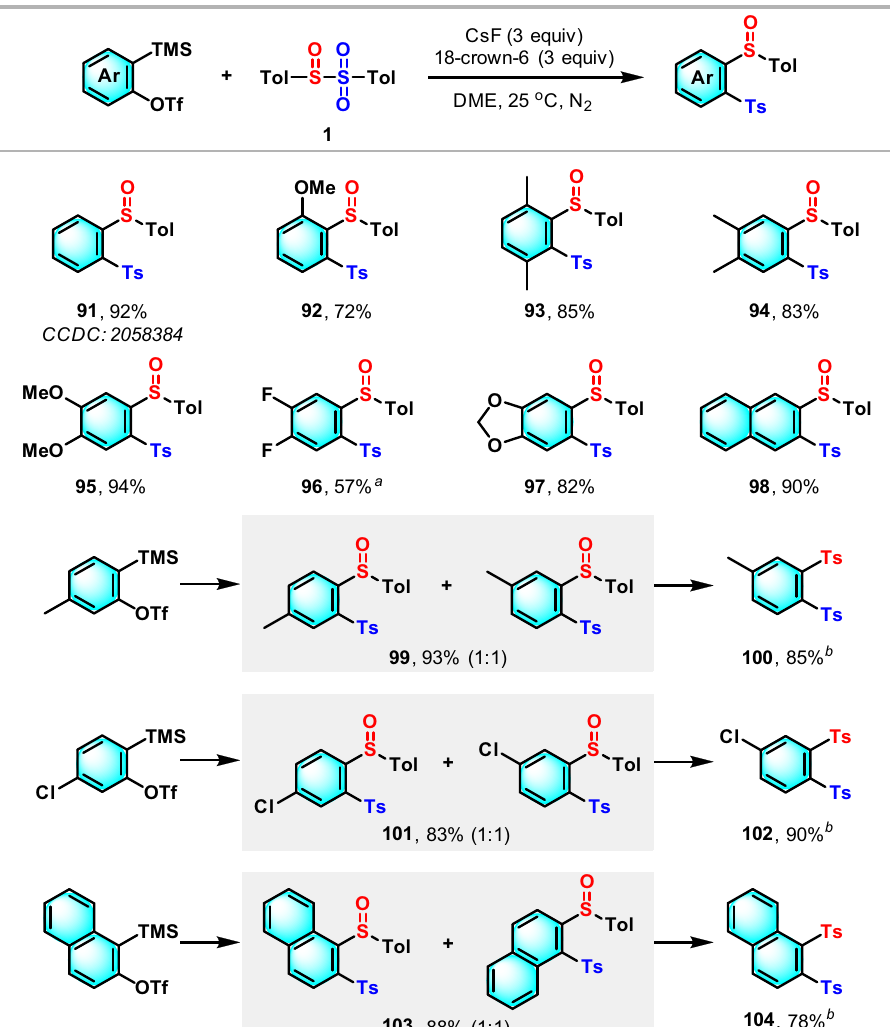
Fig. 3 The sul fi nylsulfonation of arynes. Reaction conditions: arynes (0.5 mmol), 1 (0.5 mmol), CsF (1.5 mmol), 18-crown-6 (1.5 mmol), DME (3 mL), 25 °C, N 2 , 3 h. a 0 °C, N 2 , 1 h. b 99 , 101 , or 103 (0.5 mmol), m -CPBA (0.75mmol), DCM (3 mL), 25 °C, 1